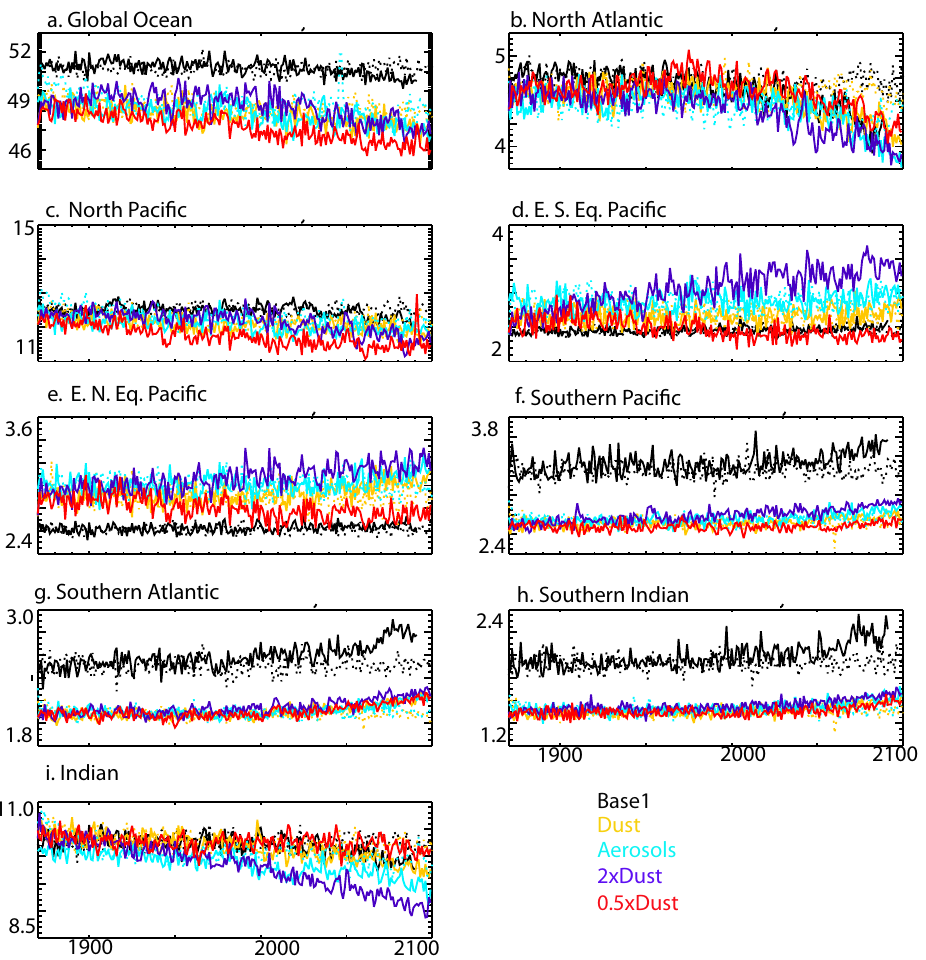
Fig. 16. Times series of ocean productivity in different regions of the ocean from 1870 to 2100 for the cases in Table 1. Regions are as in Fig. 14e. Note that different panels have different